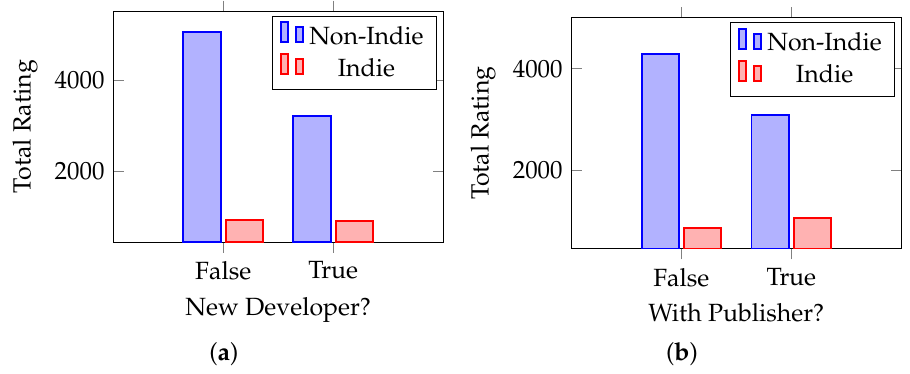
Figure 10. Average total ratings of games based on ( a ) development experience (Average total ratings of games from new or veteran developers based on non-indie and indie game developers) and ( b ) publishing options for indie and non-indie game developers (Average total ratings of games from games that are published via publishers based on non-indie and indie game